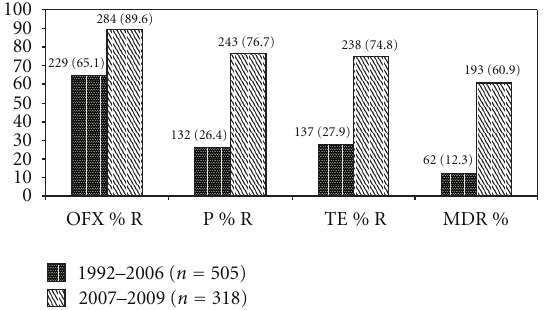
Figure 1: Comparison of resistance in Neisseria gonorrhoeae strains during years 1992–2006 and 2007–2009. There is a significant increase ( P -value < 0.01) in resistance to penicillin, tetracycline, ofloxacin, and combined resistance to all 3 antibiotics over these two periods. n is the total number of strains for that particular